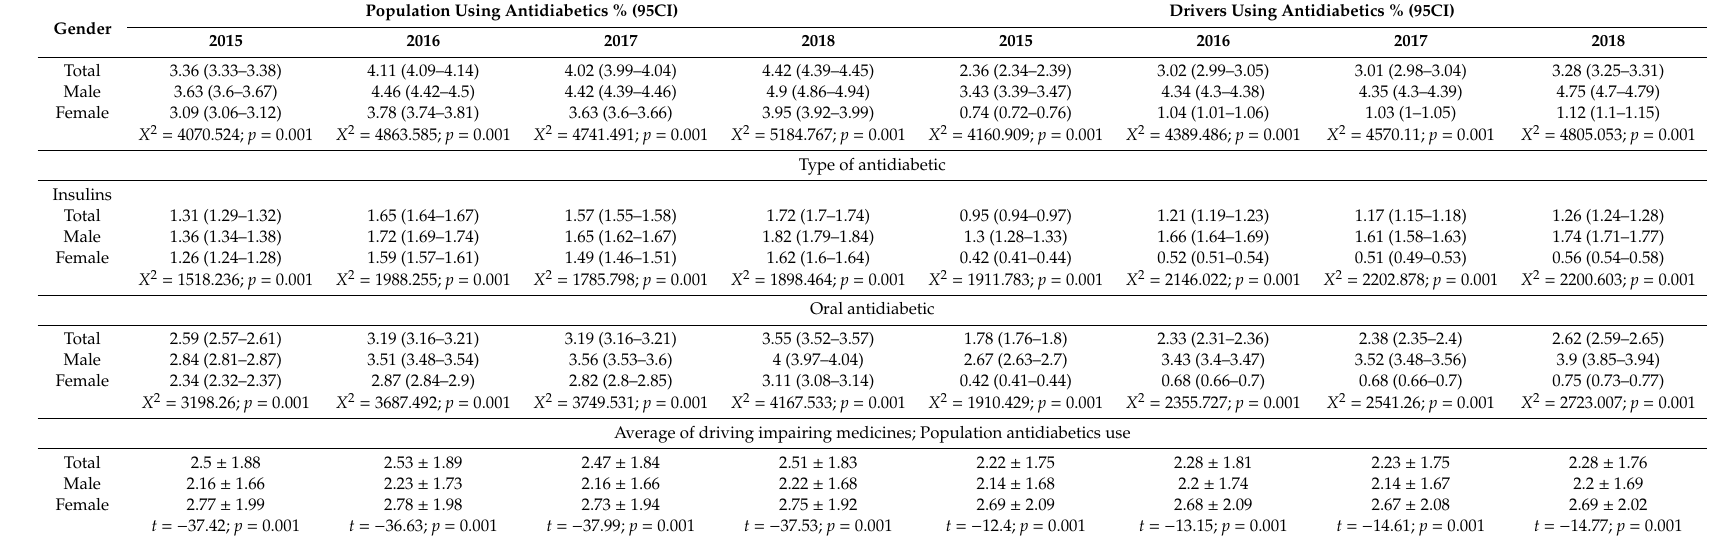
Table 2. Evolution of antidiabetics use in Castile and Le ó n